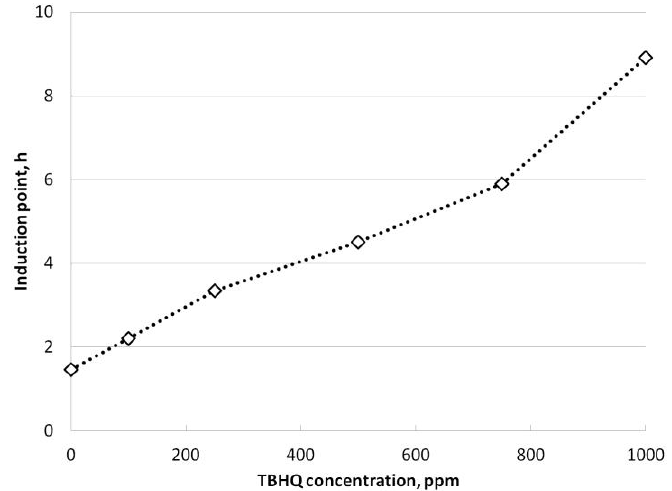
Figure 6. E ff ect of TBHQ on oxidative stability of sa ffl ower Figure 6. Effect of TBHQ on oxidative stability of safflower biodiesel.